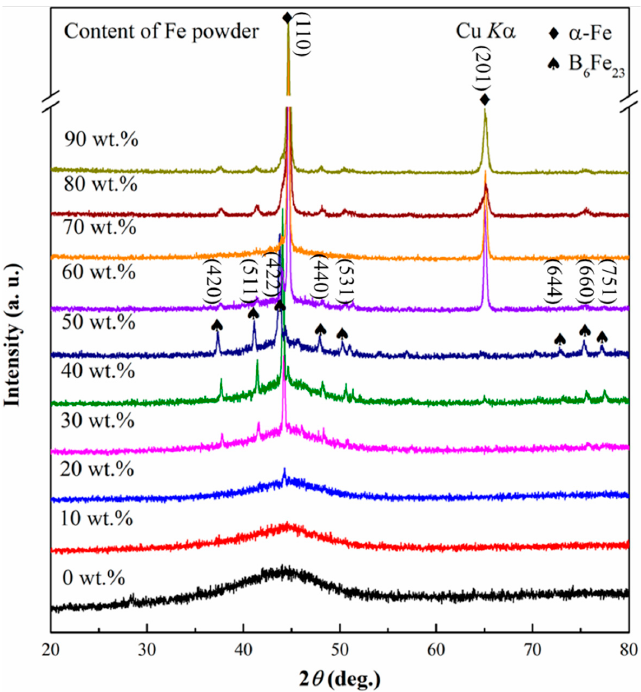
Figure 7. XRD patterns of the Co-based amorphous coating and the composite coatings produced by laser-cladding the mixtures of Co 55 Ta 10 B 35 amorphous powder with different contents of Fe